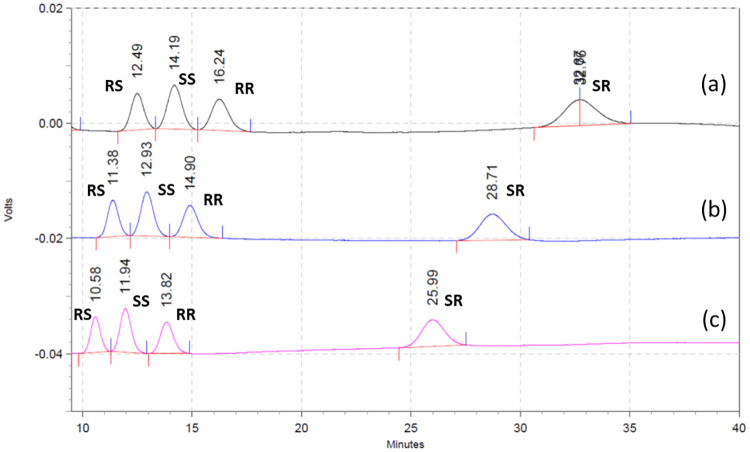
Chiral HPLC chromatograms.Using Chirex 3126 column: 60 mm × 4.6 mm; mobile phase: MeCN:2 mM CuSO4 = 15:85. a) at 25°C; b) at 30°C; c) at 35°C.